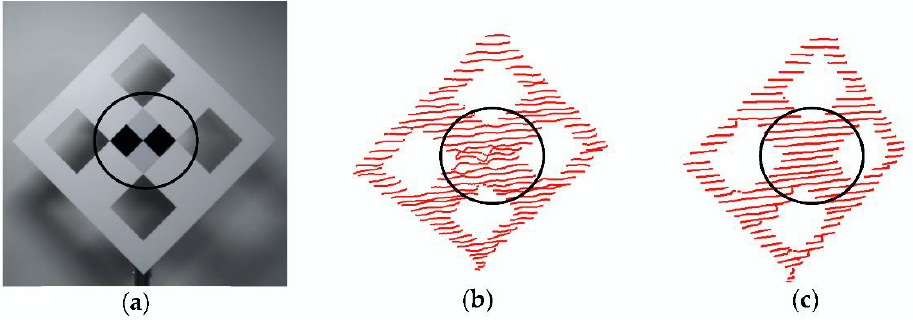
Figure 18. Influence of different colors on LiDAR ranging. ( a ) is the calibration board with one chessboard pattern, ( b ) is the affected ranging map, ( c ) is the ranging map with no chessboard pattern.